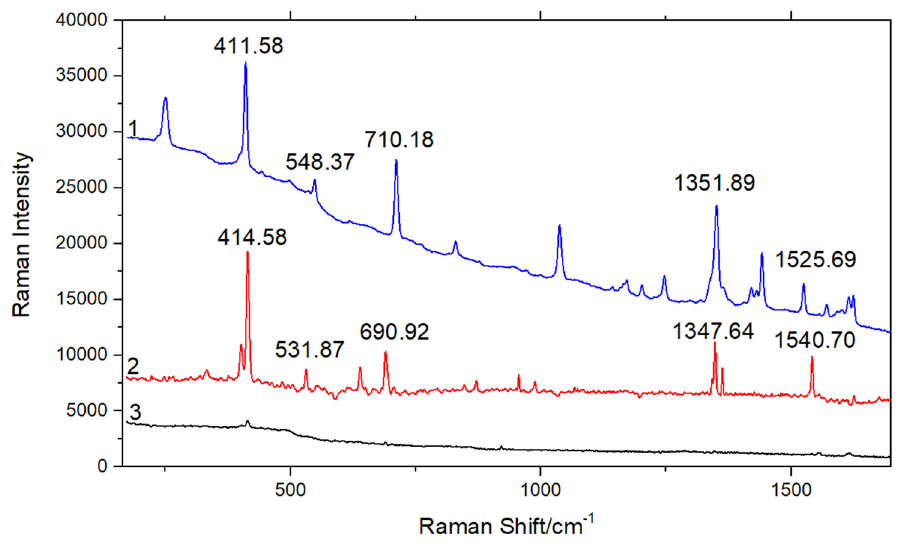
Figure 6. SERS spectra of phenanthrene. (1) phenanthrene solid; (2) 10 − 2 g/L phenanthrene SERS solution; (3) 10 − 2 g/L phenanthrene standard solution. solution; (3) 10 − 2 g/L phenanthrene standard